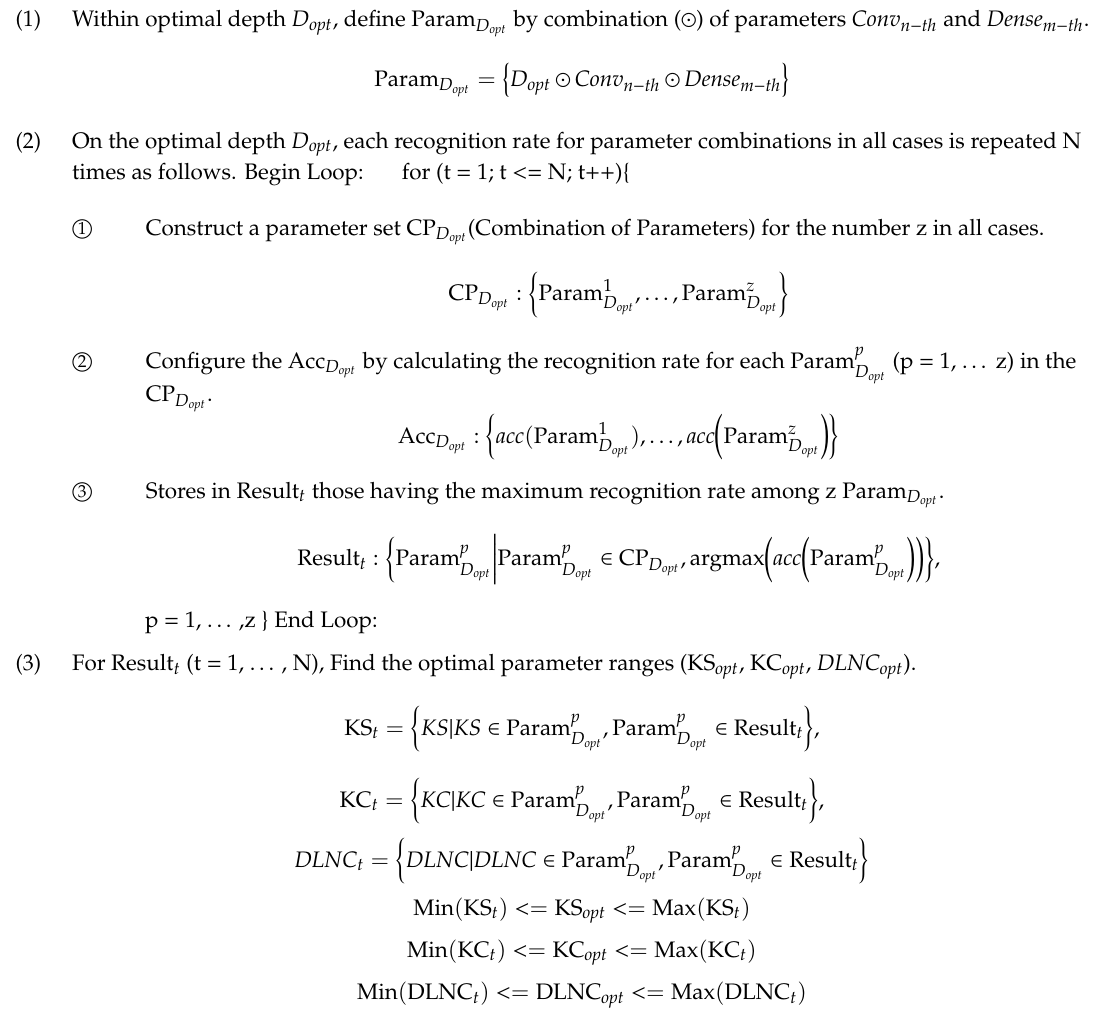
Algorithm 2 performs N iterative learning to find the optimal parameters stabilized in the convolutional layer where the depth is set, and finds the optimum parameter range composed of the parameter values in the case of the highest recognition rate for each learning. Algorithm 2 Algorithm for finding optimal range of 1-D CNN